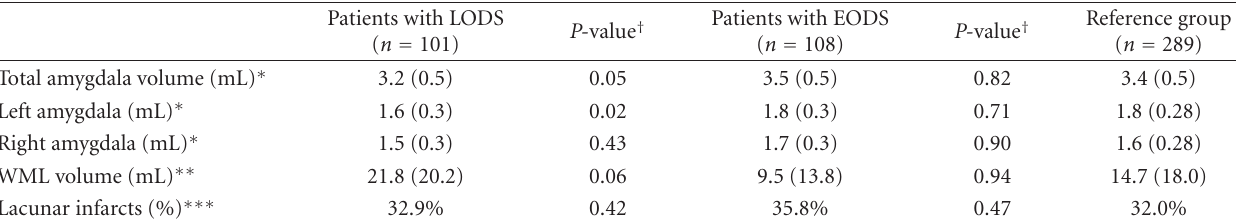
Table 2: Adjusted mean amygdala volume, White Matter Lesions (WMLs) volume, and lacunar infarcts in patients with Late Onset De- pressive Symptoms (LODSs), Early Onset Depressive Symptoms (EODSs), and patients without depressive